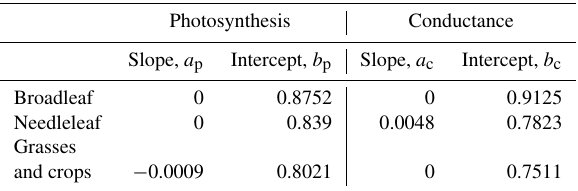
Table 1. Slopes (per mmolm − 2 ) and intercepts (unitless) used in Eqs. (4) and (5) to relate cumulative uptake of ozone (CUO) to the ozone damage factors applied to the net photosynthesis rate and stomatal conductance, following Lombardozzi et al. (2015). Values for “average” sensitivity (as opposed to “high” and “low” sensitiv- ity) are used in this